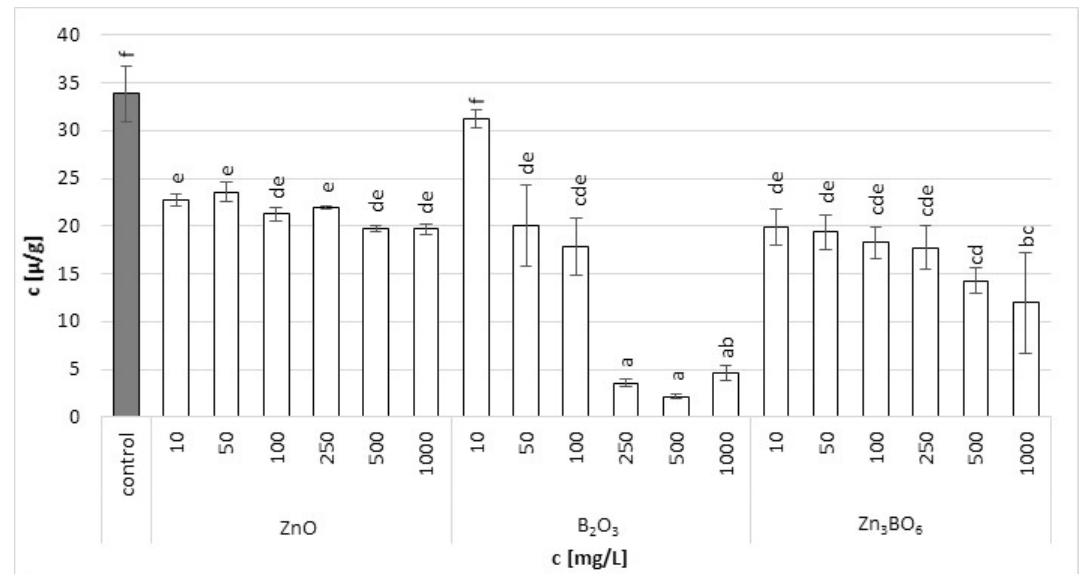
Figure 2. Chlorophyll a content in L. minor plants after 7 days of growth in the solutions supplemented with ZnO, B 2 O 3 or Zn 3 BO 6 at concentrations of 10, 50, 100, 250, 500 and 1000 mg/L. Control plants grew in Steinberg solution; standard deviation is represented as ± S.D. ( n = 3), and two-way ANOVA test with Dunnett’s multiple comparisons was